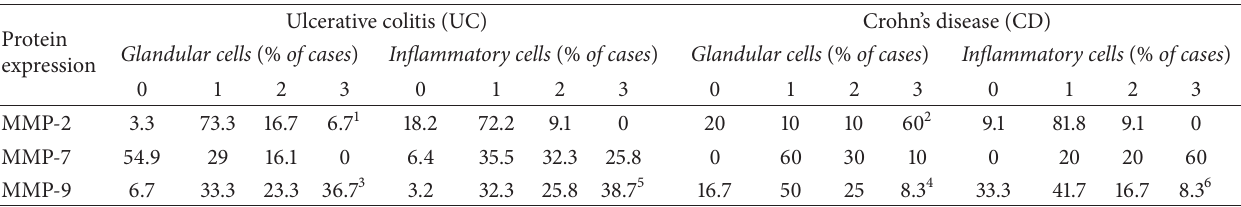
Table 2: Immunohistochemical expression of MMP-2, MMP-7, and MMP-9 in glandular tubes and inflammatory cells in tissues of ulcerative colitis and Crohn’s disease.